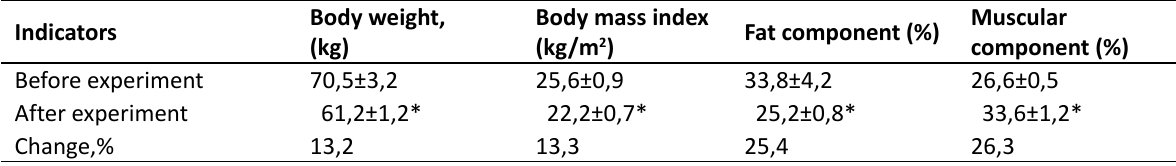
Table 2. Dynamics of women physical development indicators ( X ±m)